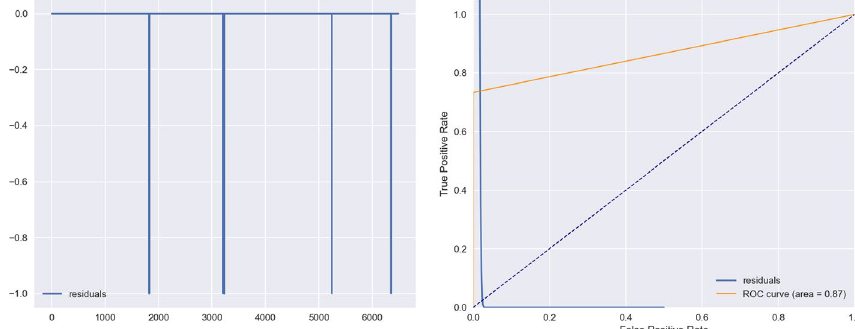
Fig. 10 Results of applying TabNet to D20 ROC curve and residual